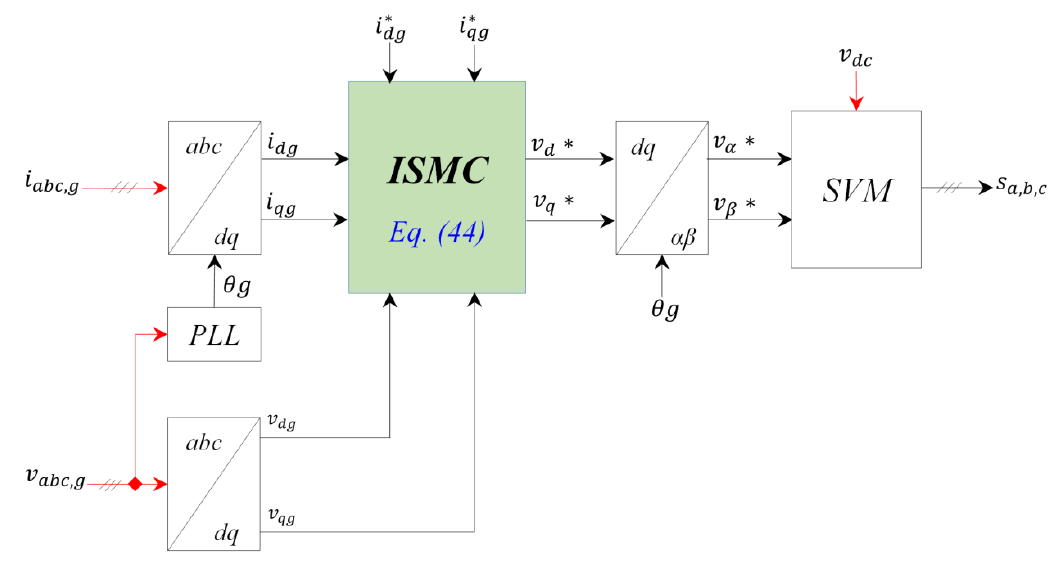
Figure 9. The proposed VOC based on ISMC.